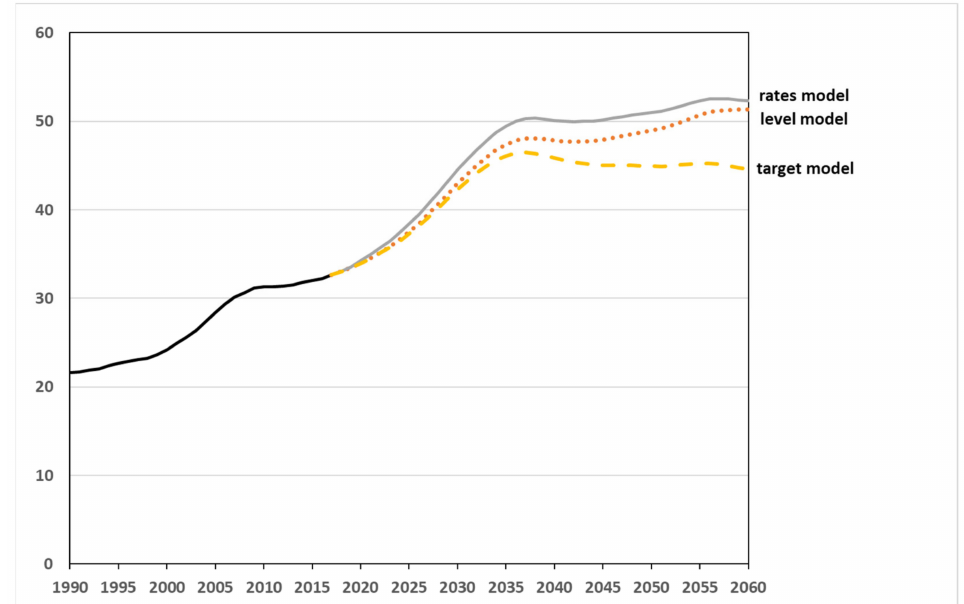
Figure 9. Development of the old-age dependency ratio (as %) until 2060—simulation results from 2019 onwards. (Sources: [64]; own computation and